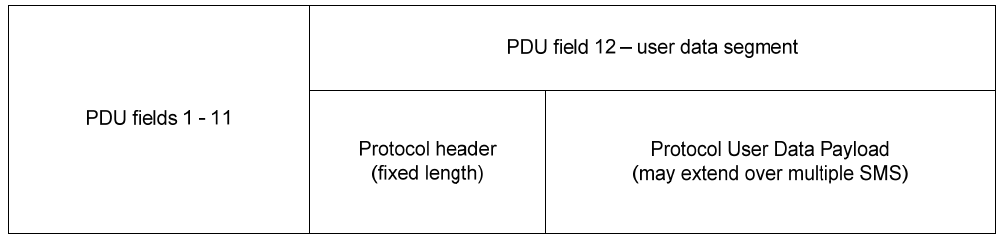
Figure 2. Fundamental structure of the SMS